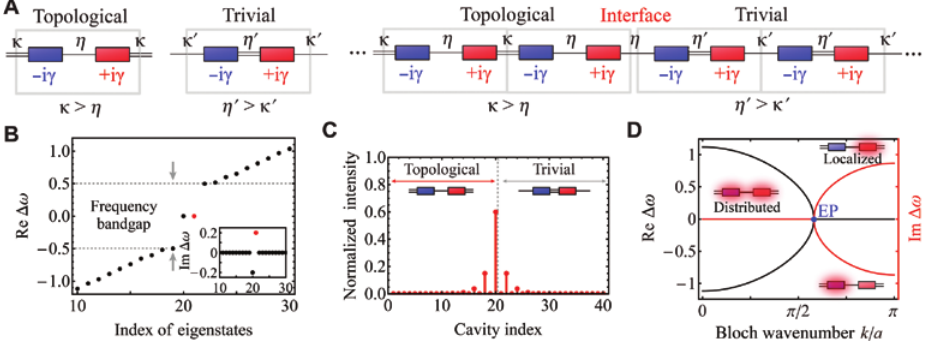
Figure 9: The complex SSH model [49], where staggered imaginary potential is applied to the system of periodic optical dimers based on two alternating couplings κ and η